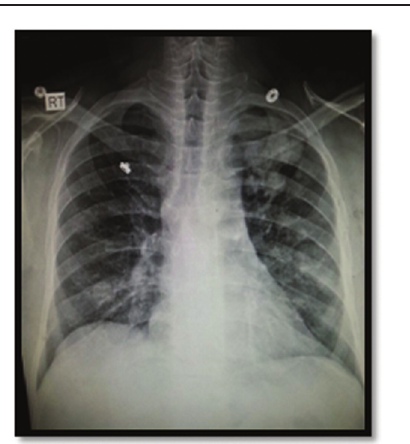
Chest radiography revealing bilateral pulmonary nodules.